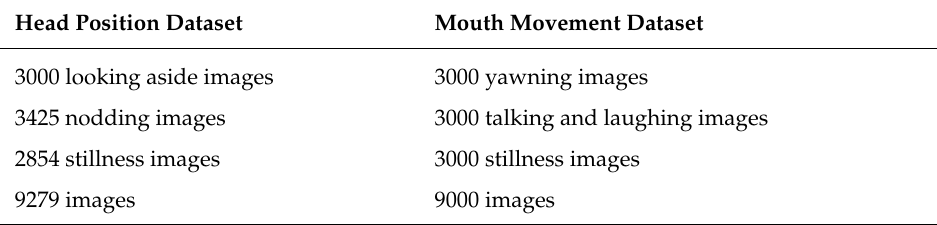
Figure 10. AlexNet as a feature extractor combined with SVM classifier. Table 8. Image count for the feature extraction